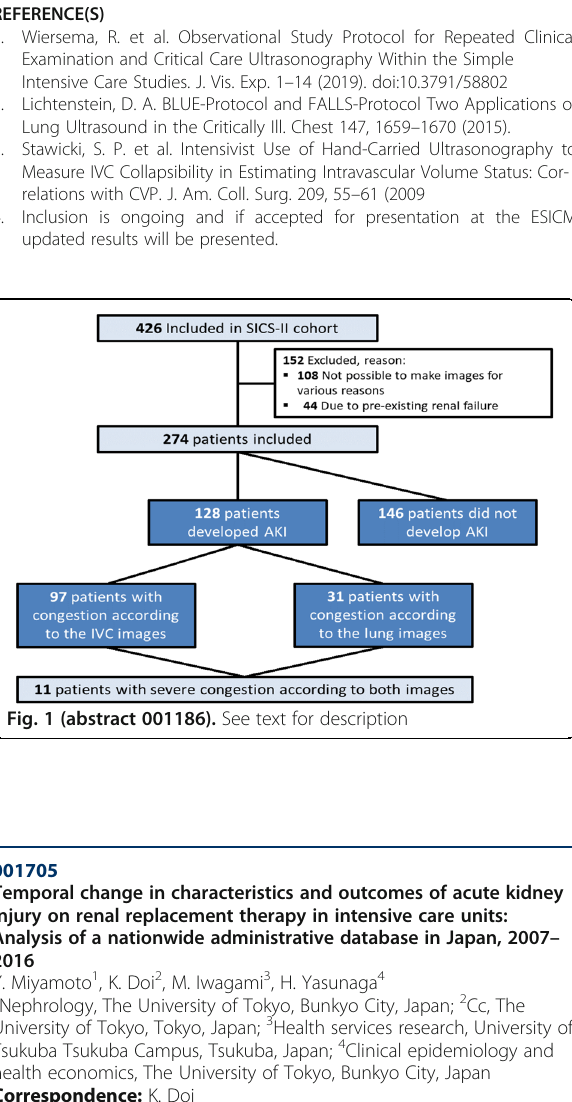
figure 1-B. The positive and negative likelihood ratio was 3.3 and 0.30,